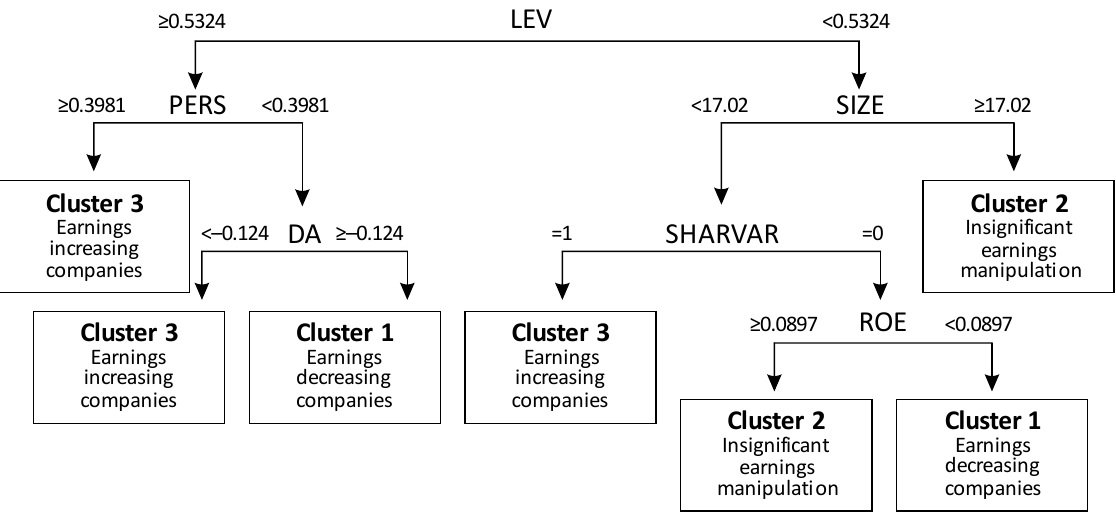
Figure 3a. Decision tree to determine clusters of earnings management (Russia)